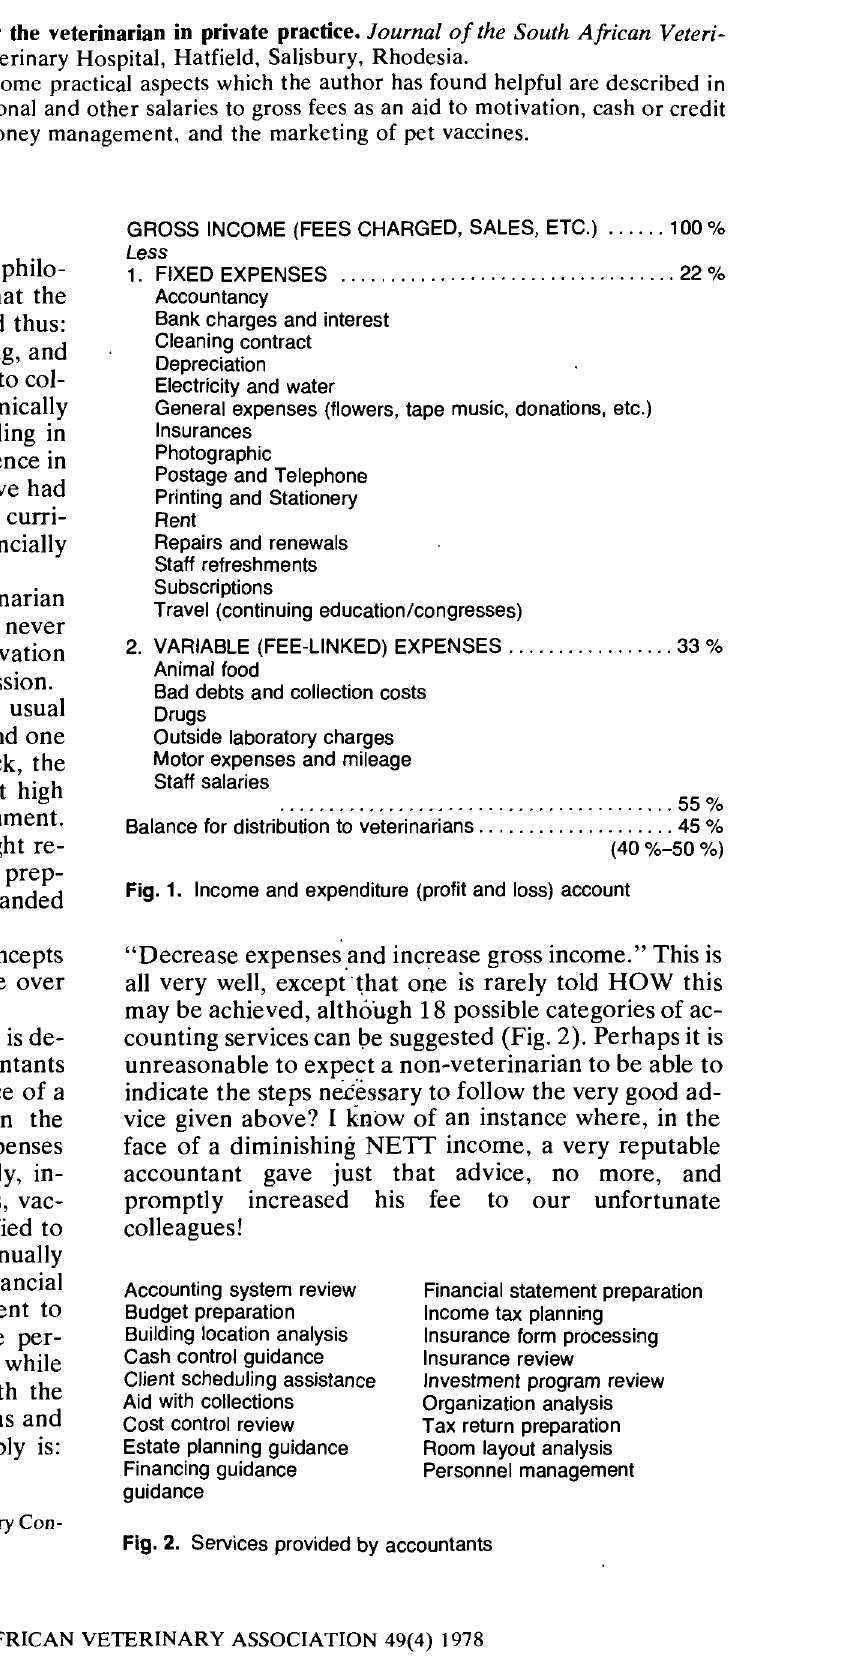
Fig. 2. Services provided by